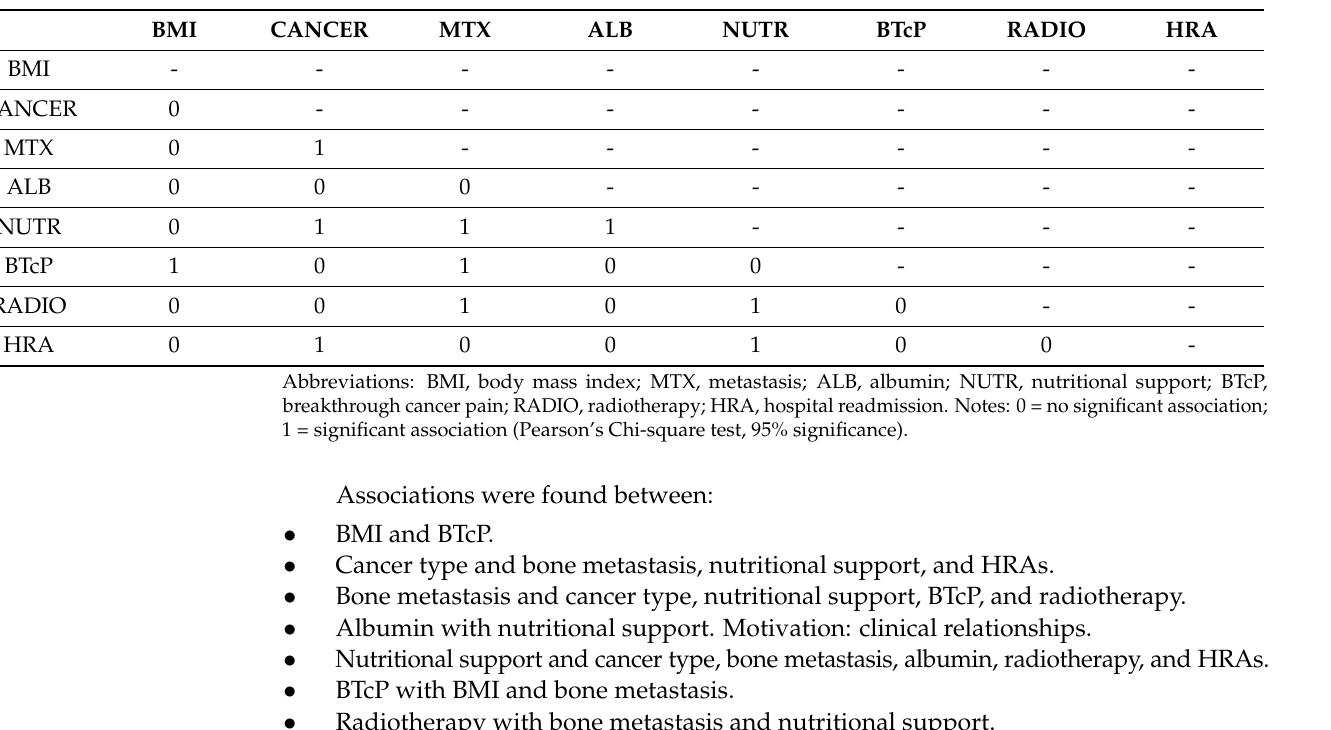
Table 3. Association